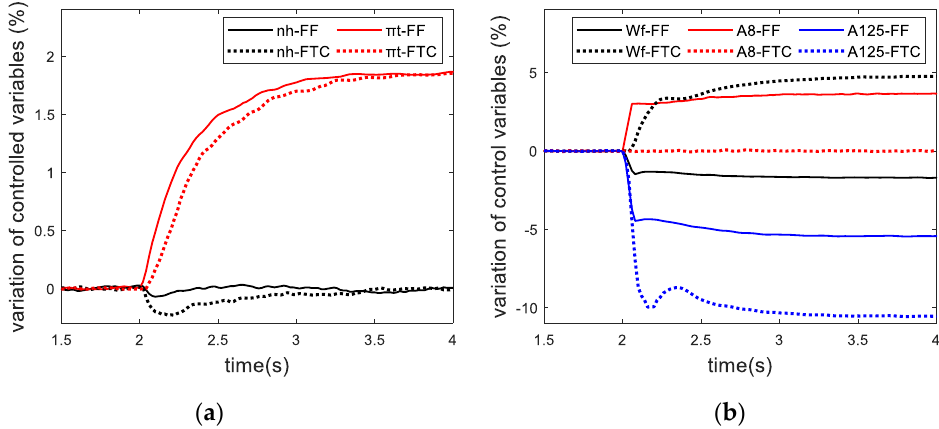
Figure 13. FTC result of SMC design in hardware-in-the-loop (HIL) test. ( a ) controlled variables ( b ) control variables.